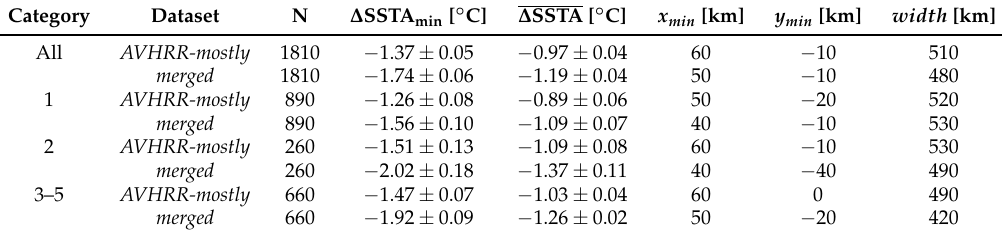
Table 1. Comparison between the mean cold wake composites of AVHRR-mostly and merged SST datasets. N refers to the number of observations. ∆ SSTA min is the minimum ∆ SSTA, ∆ SSTA is the spatial average of ∆ SSTA over a centered disk of 200 km of radius, which includes the kernel of the cold wake (the region with largest SST gradients), x min is the position of ∆ SSTA min along the x -axis (at y = 0), y min is the position of ∆ SSTA min along the y -axis (at x = 0), width (column seven) is the width of the cold wake (illustrated by colored triangles in Figure 5m,n), which we have defined as the e -folding spatial decay along the x -axis, i.e., the distance between the two points on the curve on the ∆ SSTA x -axis where . Uncertainties for all values of x min , y min and width are of 10 km, as stated by the min e grid resolution of the interpolated mesh, which is a larger value than the margin of